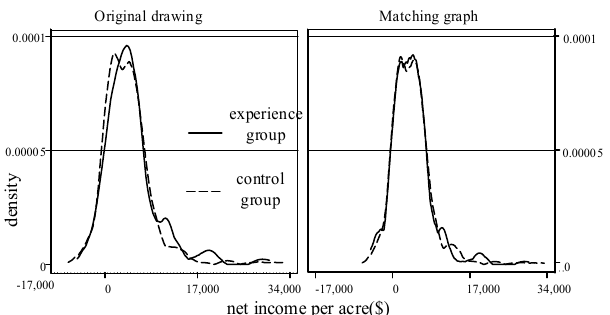
Figure 6. Average net income balance test.